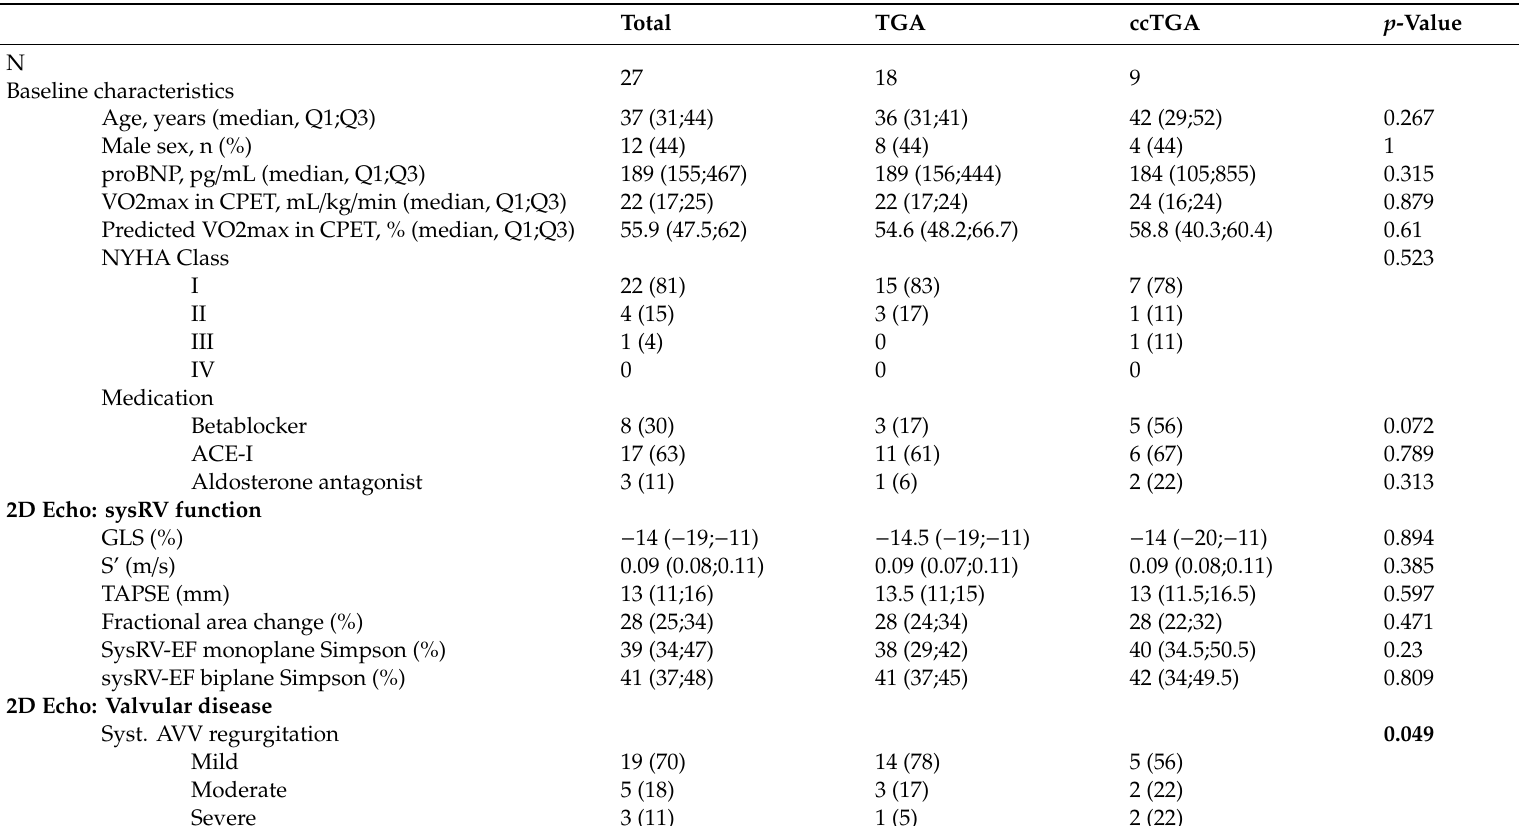
Table 1. Baseline characteristics and 2D echocardiography data. NYHA = New York heart association, ACE-I = angiotensin-converting-enzyme inhibitor, sysRV = systemic right ventricle, GLS = global longitudinal strain, TAPSE = tricuspid annular plane systolic excursion, AVV = atrio-ventricular valve, TGA = transposition of the great arteries, ccTGA = concentially-corrected transposition of the great arteries. Total TGA ccTGA p -Value